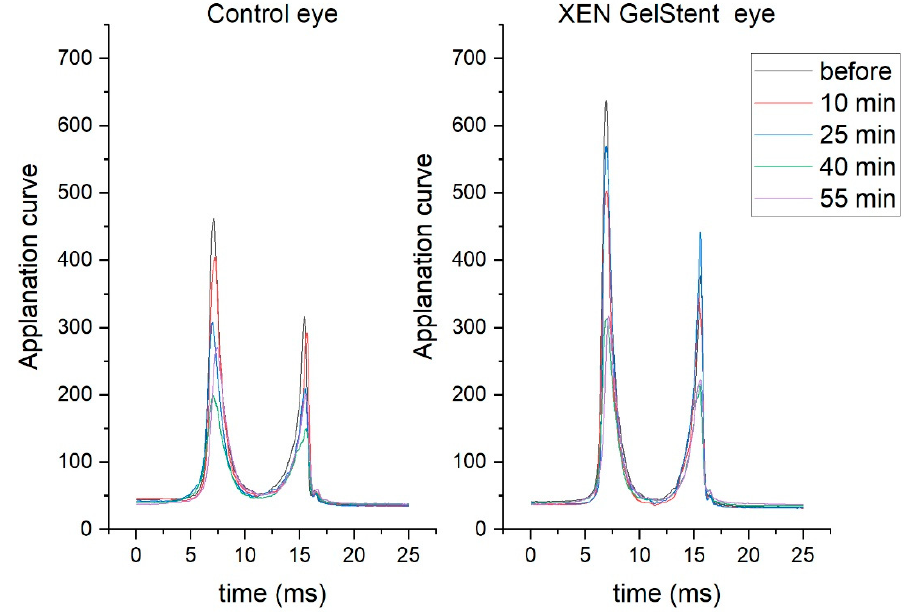
Figure 2. Exemplary applanation curves for one patient during the water drinking test.